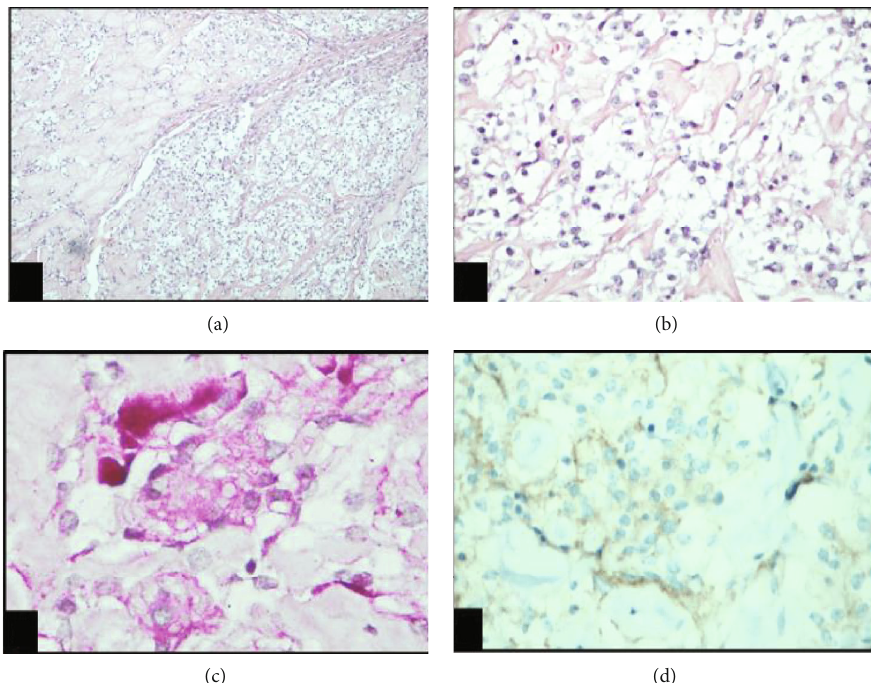
Figure 6: (a) Clear cell meningioma exhibiting sheets of round to polygonal cells arranged in a haphazard manner alternating with areas with thick bulky interstitial collagenization (H&E, 100x). (b) High magni fi cation image shows lesional cells with clear cytoplasm (H&E, 400x). (c) The cytoplasm contains glycogen demonstrated by periodic acid-Schi ff (PAS; 400x). (d) Weak membranous immunoreactivity for epithelial membrane antigen (IHC, 400x).